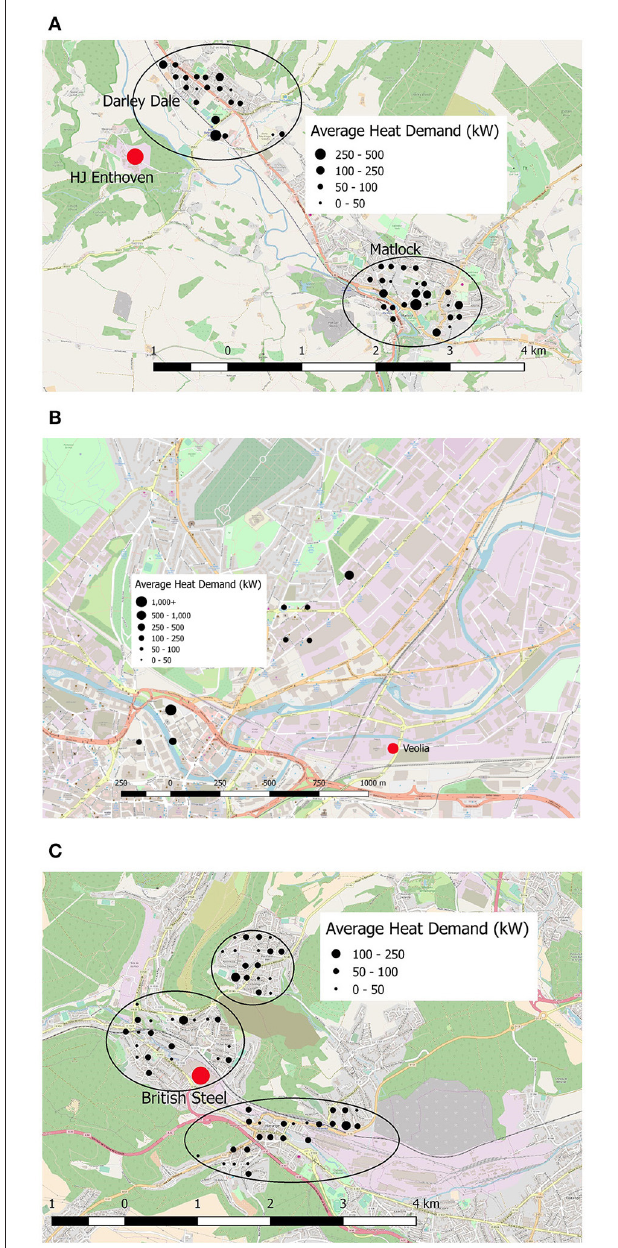
FIGURE 2 | The size and locations of the heat source (in red) and customers (in black), showing the clusters of heat customers (in black rings) in each case study area. (A) GIS map showing the heat source and customers in case study 1: Darley, England. (B) GIS map showing the heat source and customers in case study 2: Sheffield, England. (C) GIS map showing the heat source and customers in case study 3: Hayange, France (Geofabrik, 2017).